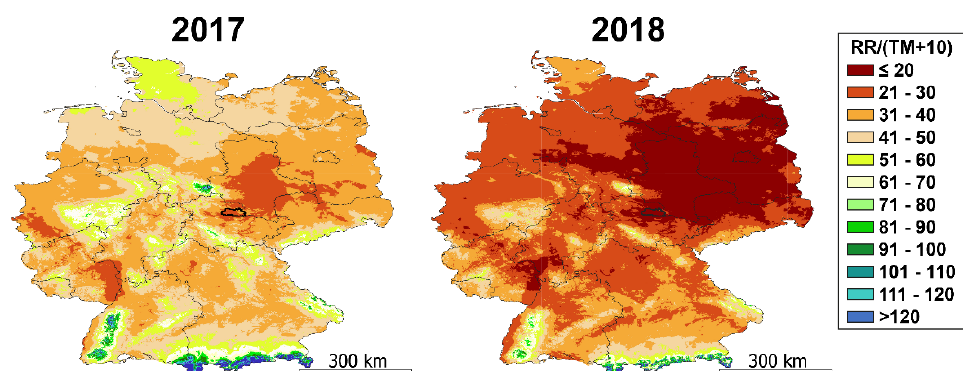
Figure 2. Comparison of the aridity in Germany. Maps show the spatial variation in annual drought index (De Martonne aridity index, I DM ) for Germany in the years 2017 (left) and 2018 (right) and the map scale. All values are calculated using the formula: RR/(TM+10), where RR is the annual sum of precipitation (in mm) and TM is the annual mean air temperature (in °C). Lower index values refer to more pronounced aridity at respective location. The sample origin is highlighted with a thick line and shows index values below 30 in 2017 (humid to Mediterranean) and values below 20 in 2018 (semi-dry to dry).